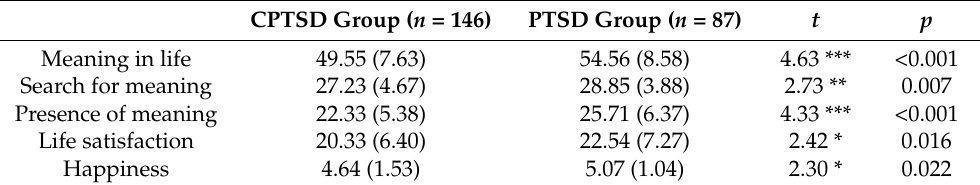
Table 3. Differences in meaning in life, life satisfaction, and happiness between the CPTSD group ( n = 146) and the PTSD group ( n =